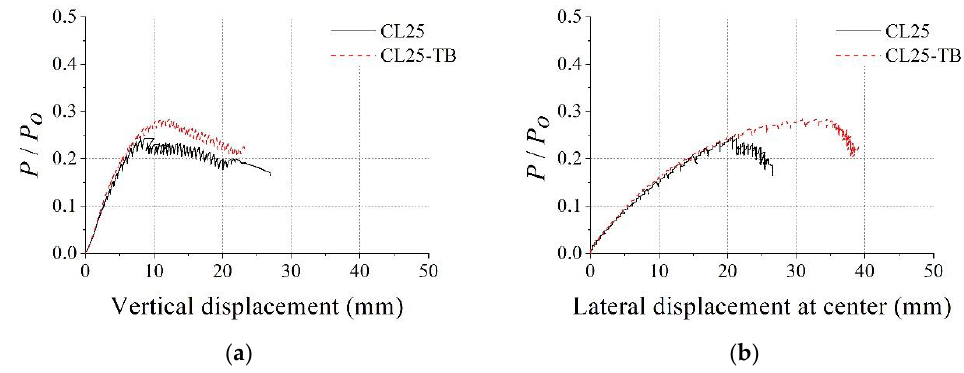
Figure 11. Failure shape: ( a ) CL25; ( b ) CL25-TB.